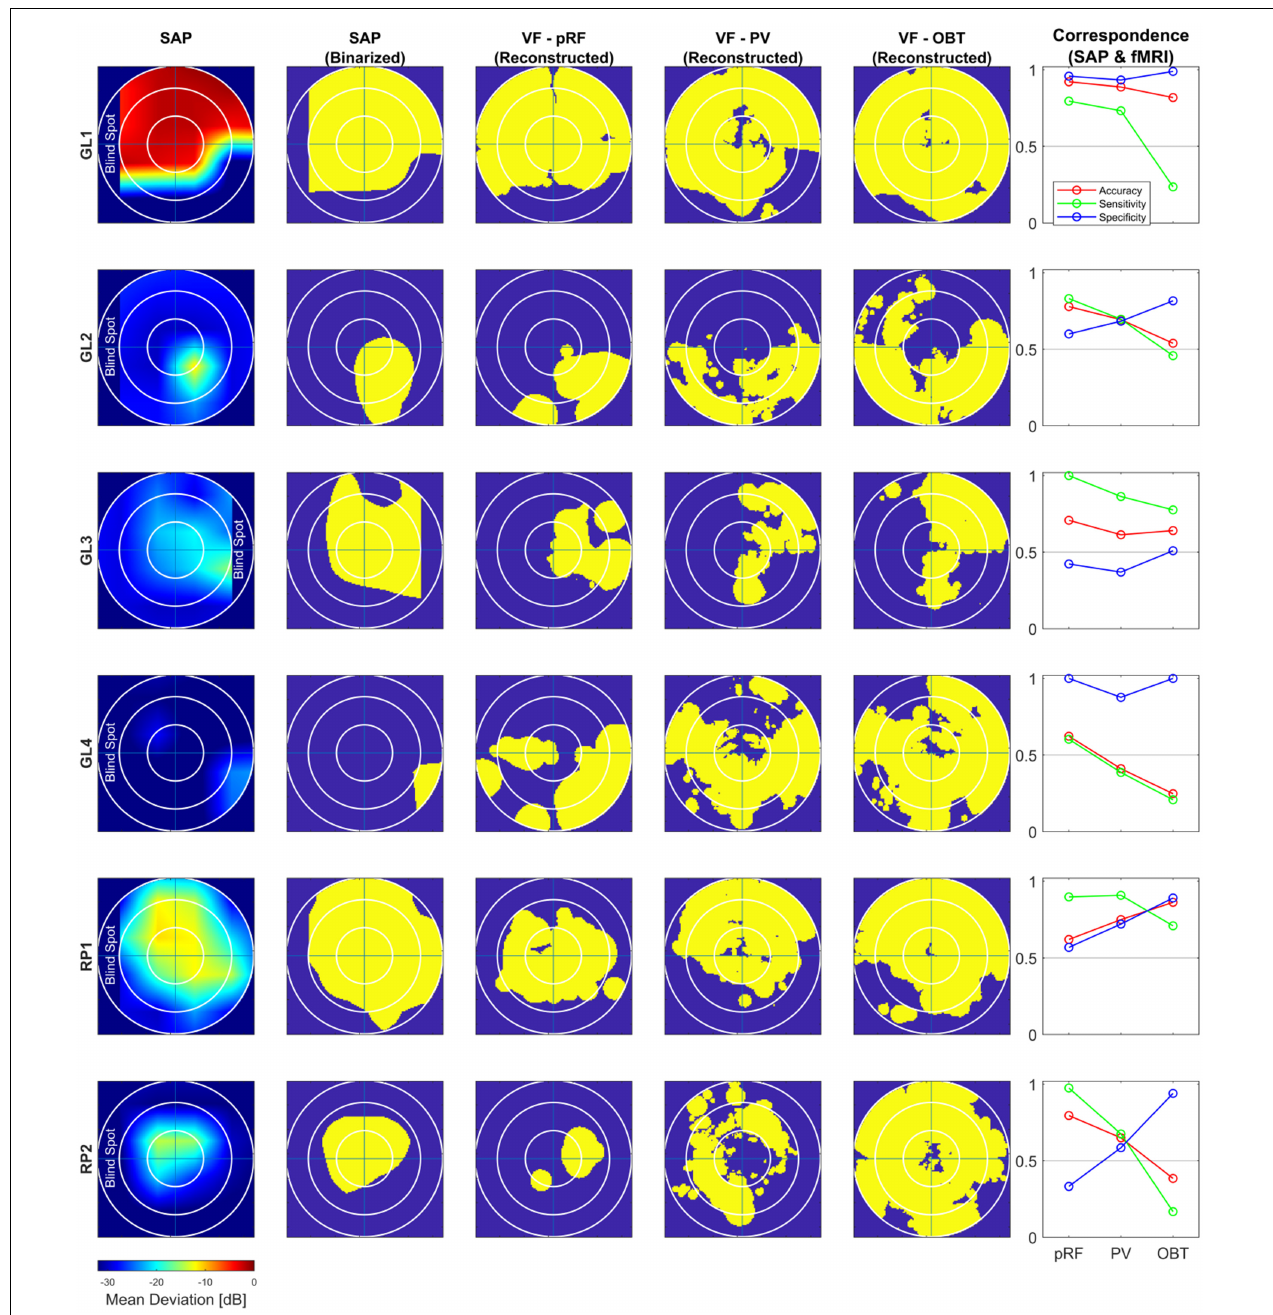
FIGURE 3 | Comparison of subjective (SAP) and objective (fMRI) VF-reconstruction (V1–V3-pooled) in patients. Each row represents one participant, the description for the columnar subplots are as follows: SAP: Upsampled and interpolated SAP VFs for the central 14 ◦ (radius); SAP (Binarized): Binarization was performed by thresholding the SAP VFs into responsive (yellow) (MD ≤ –26) and non-responsive (scotoma) (MD > –26) locations; Columns VF – pRF, PV and OBT: Binarized pRF-based and atlas-based (PV and OBT) coverage maps, thresholded at a pRF coverage of 0.7; Correspondence (SAP and fMRI): accuracy; sensitivity; specificity for the different fMRI approaches (pRF, PV, and OBT) visualized as line